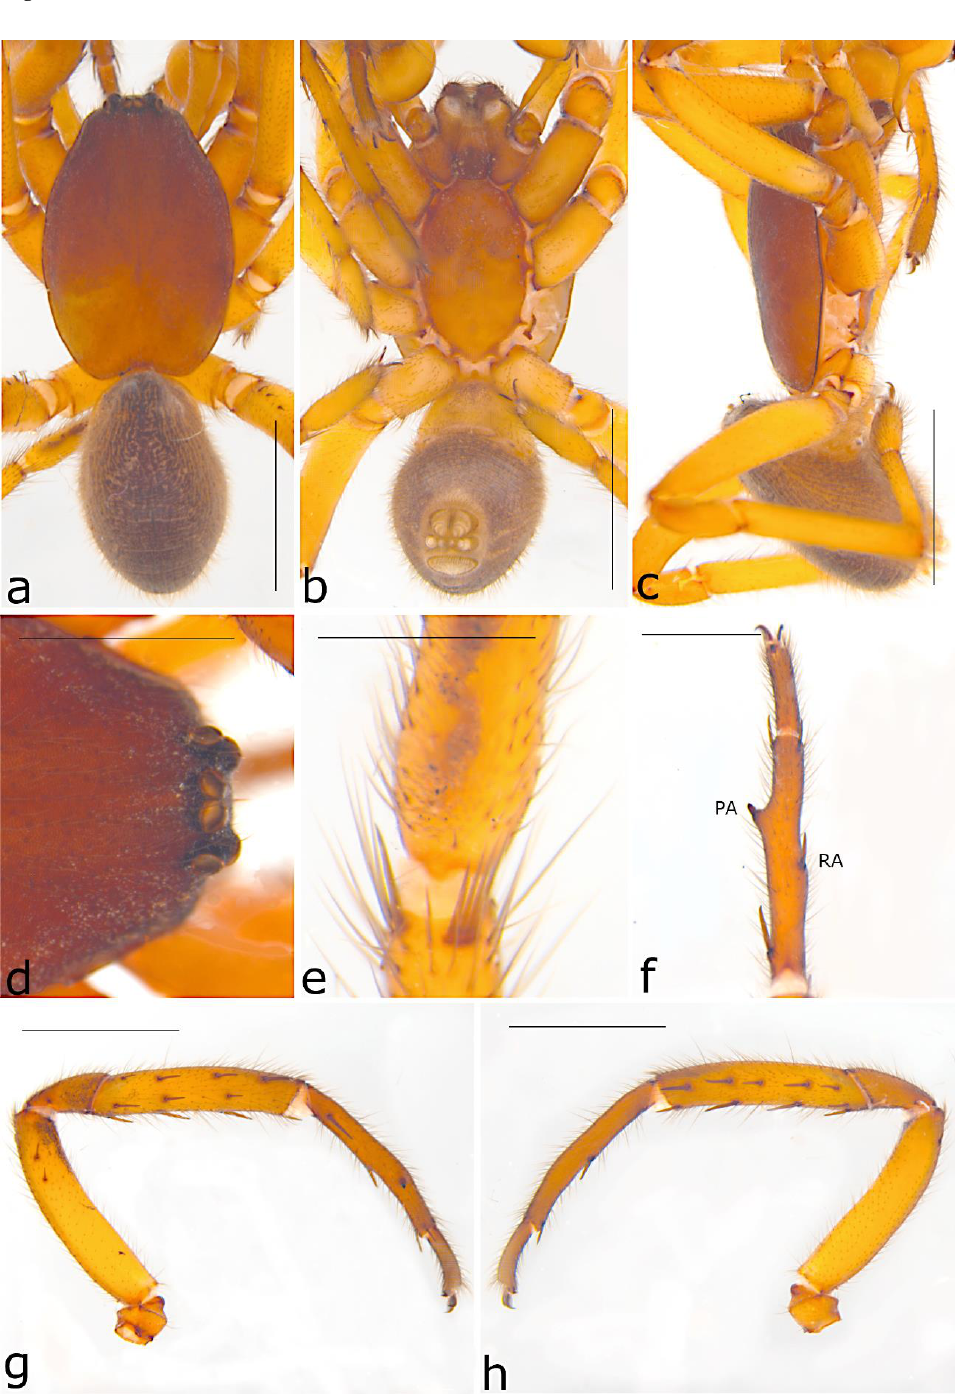
Figure 40. Ariadna inflata sp. nov. ♂ holotype (SAMA NN22460) from Yorke Peninsula (SA): ( a ) habitus, dorsal view; ( b ) same, ventral view; ( c ) same, lateral view; ( d ) eyes, dorsal view; ( e ) left metatarsus IV, preening comb, retrolateral view; ( f ) left leg I, ventral view; ( g ) same, prolateral view; ( h ) same, retrolateral view. Scale bars ( a – c ) = 2 mm, ( d ) = 1 mm, ( e ) = 0.5 mm, ( f ) = 1 mm and ( g , h ) = 2